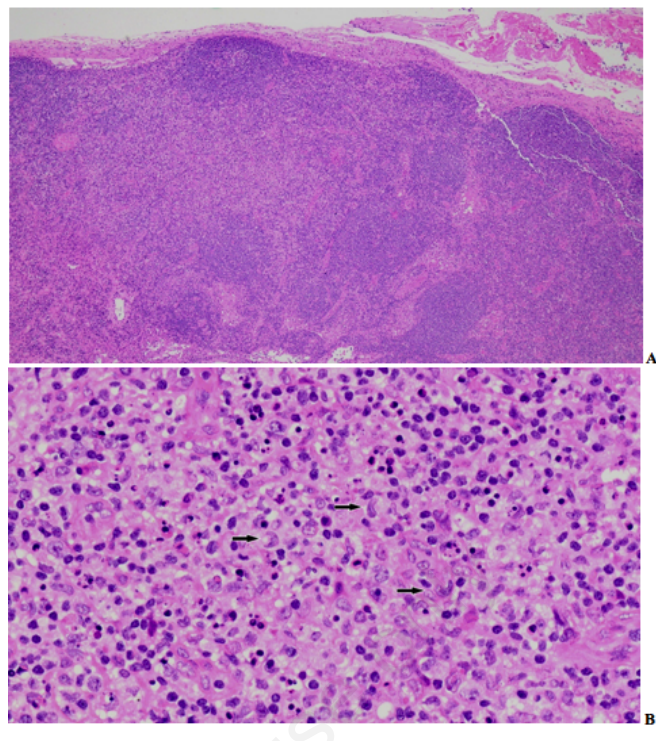
Figure 1. A) The largest lymph node contains patchy foci of extensive paracortical necro- sis (H&E, 2X). B) The necrotic area contains many histiocytes admixed with lympho- cytes and extensive karyorrhectic nuclear debris. Many of these histiocytes display dis- tinctive elongated, twisted, or crescentic nuclei (arrows). Of note, there are no neu- trophils or plasma cells within the area of necrosis (H&E, 40X).